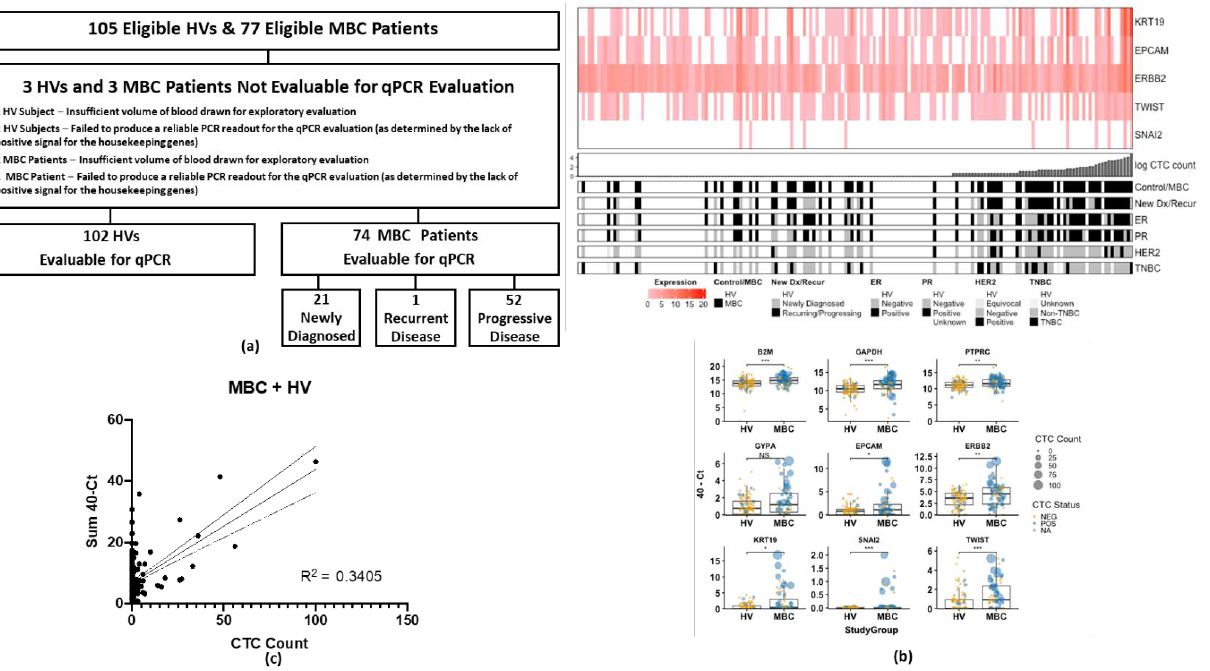
Figure 3. ( a ) Flow diagram for qPCR evaluation in eligible HV and MBC patients. ( b ) CTC count correlates with total CTC-related gene expression (40-Sum of KRT19, EPCAM, ERBB2, TWIST, and SNAI2 Ct values). Heat map and scatter plots of CTC gene expression show correlation of gene expression with the number of CTCs observed ( c ) Sum CTC related genes expression = 0.3701 * CTC count + 6.771; R square = 0.3405, slope significantly different from zero ( p < 0.0001). HV, healthy volunteer; MBC, metastatic breast cancer; qPCR, quantitative polymerase chain reaction. NS = p ≥0.05, * p < 0.05, ** p < 0.01, *** p < 0.001. from the cytology evaluation are summarized in Table 4. A total of 18 negative controls (nuclease-free water) and 18 positive controls (SUM149 cell lysate) were compared with